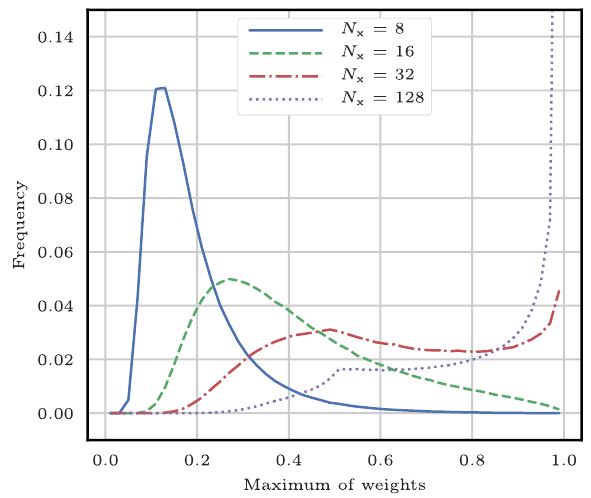
Figure 1. Empirical statistics of the maximum of the weights for one importance sampling step applied to the Gaussian linear model of Appendix A1. The model parameters are p = 1, a = 1, h = 1, q = 1, and σ = 1, the ensemble size is N e = 128, and the system size varies from N x = 8 (well-balanced case) to N x = 128 (almost degenerate